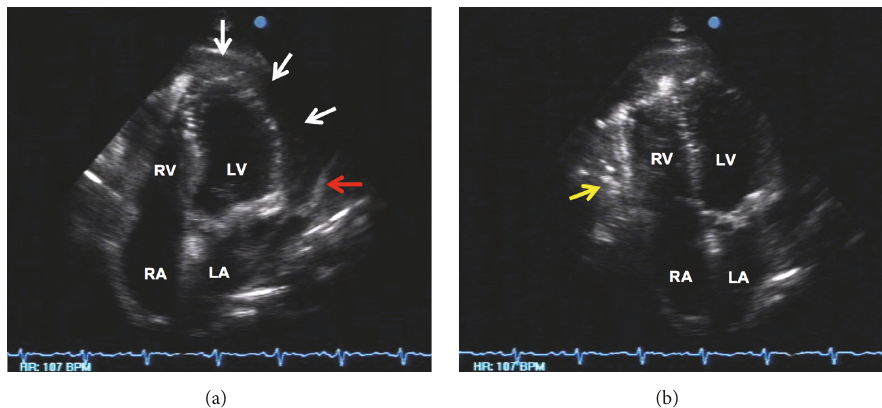
Figure 3: Echocardiographic apical four-chamber views demonstrating pneumopericardium. (a) There was a large (20 mm) circumferential layer (white arrows) within the pericardial space, with its heterogenous nature suggestive of possibly purulent pericardial fluid. Marked thickening of the pericardium (5mm) can also be appreciated in this view (red arrow). (b) Slight angulation of the probe to focus on the anterior pericardial space (anterior to the right ventricle) revealed the presence of microbubbles (yellow arrow) representing air freely moving within the pericardial sac.